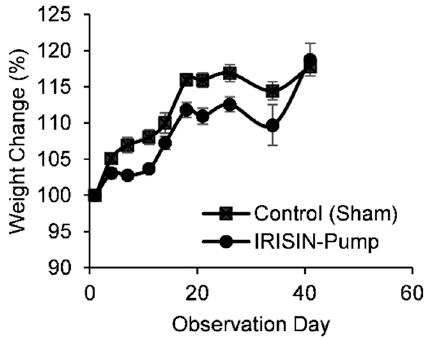
Figure 1. Percent weight change of rats administered with irisin via the osmotic pump ( n = 10). Irisin reduced body weight up to 5% from day 7 and up to day 34 of administration. For example, average body weight dropped from around 209 g to 196 g at day 21 of administration.